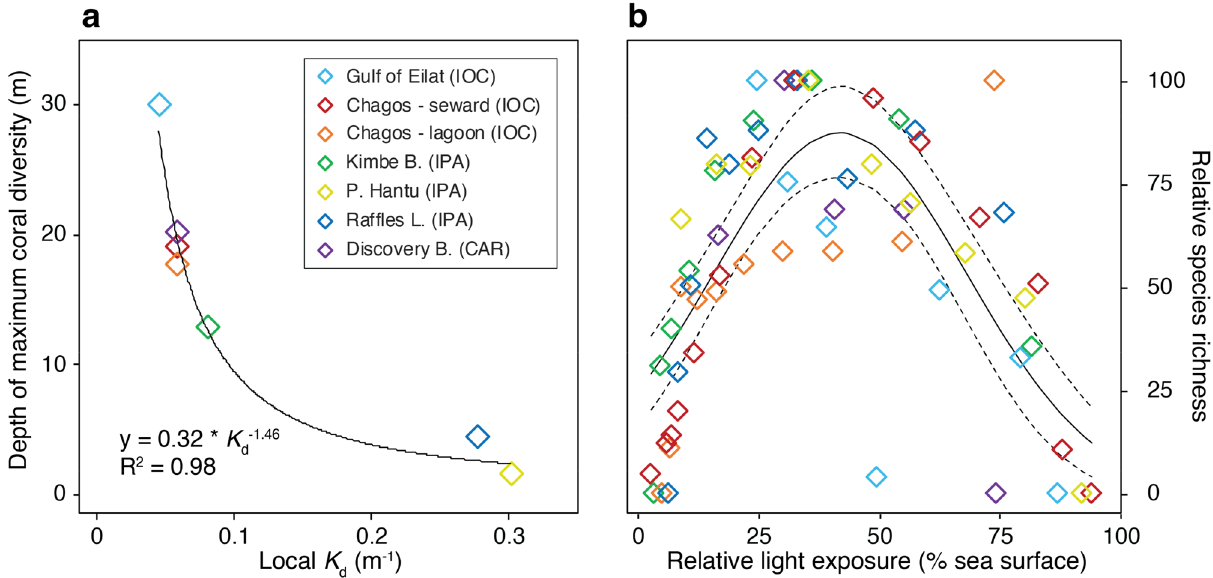
Figure 3. Relationship between the distribution of coral species richness and the water optical properties. ( a ) Vertical attenuation coefficient for downwelling irradiance ( K d ) versus the depth of maximum diversity by location. A power function depicted in the figure was used to fit a linear regression to the data. ( b ) Variation in coral species richness along a light intensity gradient determined by the local K d . Relative light exposure is reported in % of sea surface. The overall data was fitted using a gaussian function (continuous line) with 95% confidence intervals (discontinuous